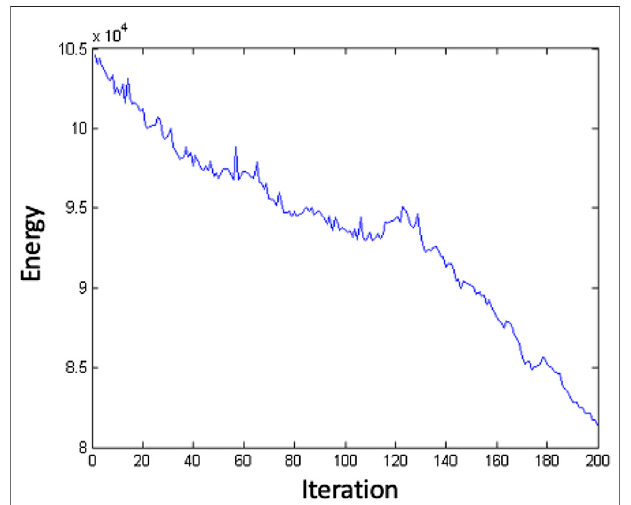
FIGURE 12 | How energy decrease by iteration in Simulated annealing method results, for example with the initial guess set l 1 is random with T 0 (cid:2) 10 , Δ T (cid:2) 0 . 01 and the maximum random step is 20.